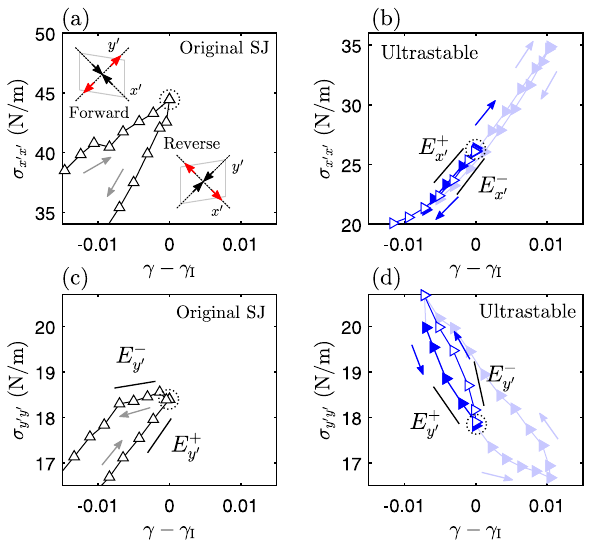
and E x 0 y 0 y 0 I